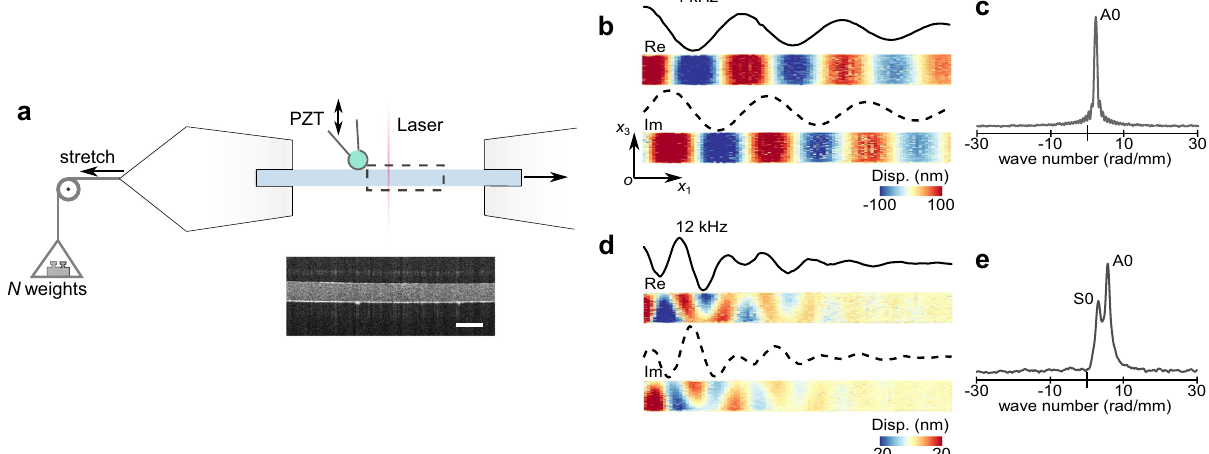
Fig. 5 Measuring the speed of Lamb waves in a stretched rubber thin fi lm with Optical Coherence Tomography (OCT). a Schematic of the experimental setup. The OCT operates synchronously with the piezoelectric transducer (PZT) probe to perform an motion-brightness (M-B) scan. Inset, OCT transverse image of the fi lm (scale bar, 2 mm). b Real and imaginary parts of the displacement fi eld when the stimulus frequency is 4 kHz. The curves show the displacements extracted from the upper surface of the sample. c , Wavenumber domain data obtained by Fourier transform of the spatial domain data. A peak corresponding to the A0 mode can be clearly identi fi ed from this curve. d , e Spatial and wavenumber domain data obtained at 12 kHz. Two peaks, corresponding to the A0 and S0 modes, can be identi fi ed from the wavenumber domain